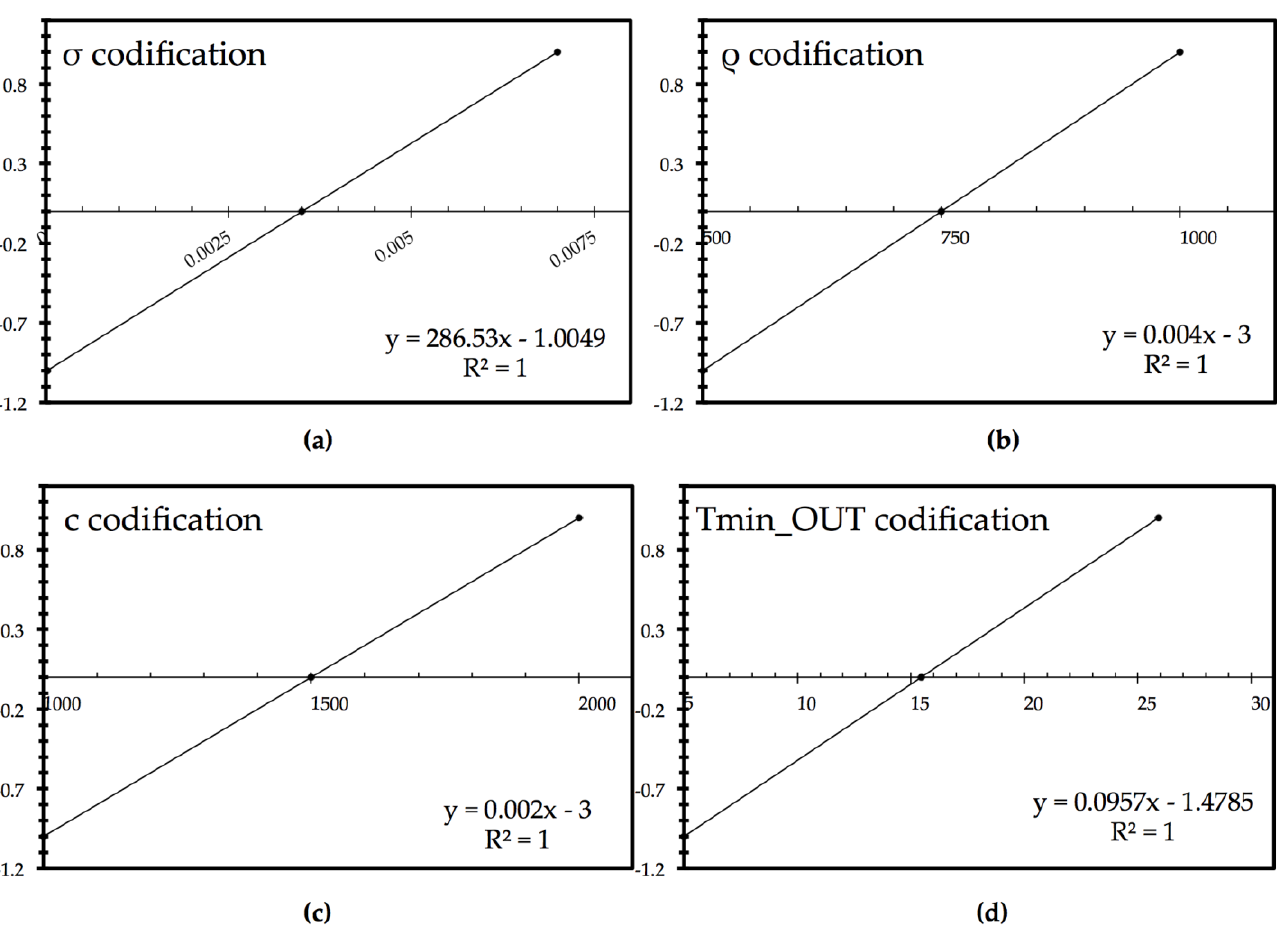
Figure 5. Codification equations for each parameter. Each parameter had to be codified before using the regression equation that resulted from the Hoke D6 simulation scenarios. y axis—codified values; x axis—real values for ( a ) fabric thickness σ , ( b ) fabric density ρ , ( c ) fabric thermal capacity c p , and ( d ) minimum outside temperature T out_min .